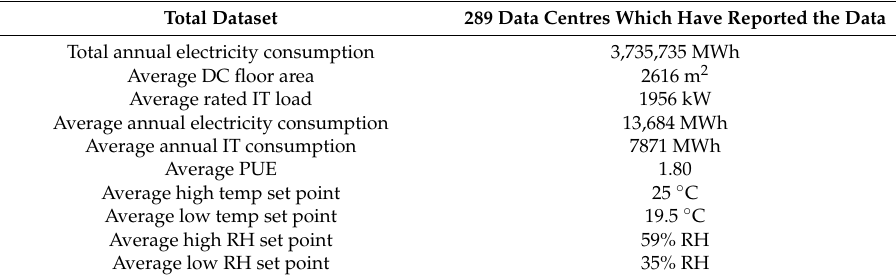
Table 2. Average data of reported facilities.